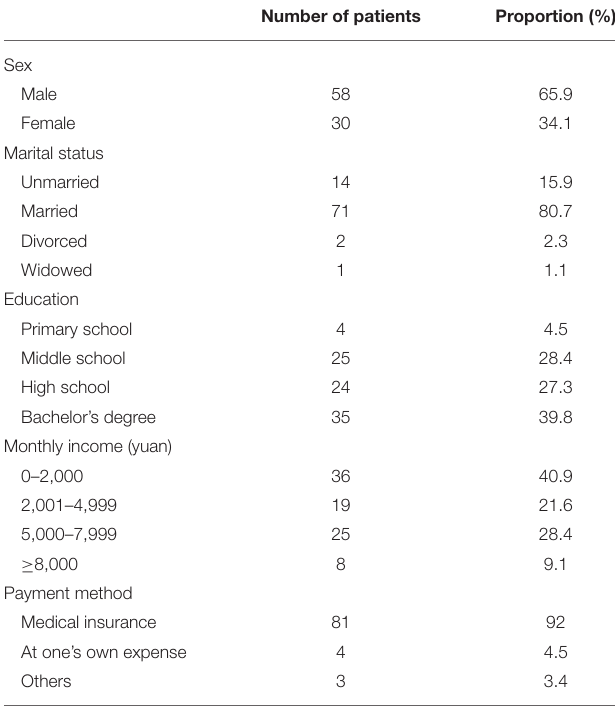
TABLE 1 | Patients’ demographic characteristics ( n =